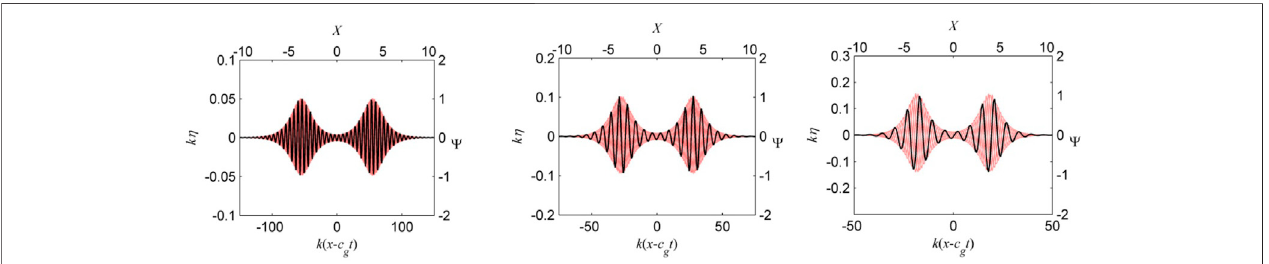
FIGURE 5 | Initial conditions for the numerical simulations of the degenerate soliton. Left panel : ka (cid:2) 0.05. Middle panel : ka (cid:2) 0.1. Right panel : ka (cid:2) 0.15. The axes show the physical scaled coordinate and surface displacement ( y- axis left ), the standard NSLE coordinate X (cid:2) k ( x − c g t ) ( x- axis) and the complex amplitude Ψ (cid:2) k (cid:7) √ η ( y -axis right ). a 2